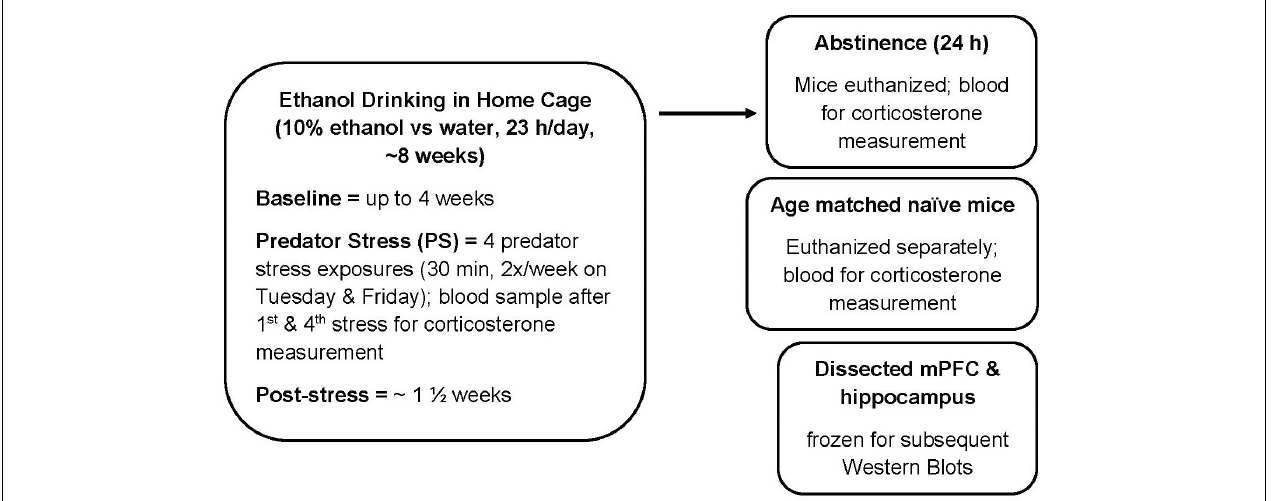
FIGURE 1 | Experimental timeline. Male and female C57BL/6J mice were treated as described. Ethanol drinking (10% ethanol vs. water) was measured for 23 h per day in the home cage. Predator stress (PS) exposure occurred twice per week for 2 weeks, where mice were exposed to dirty rat bedding for 30 min. After the fourth PS exposure, post-stress drinking was measured for approximately 1 1/2 weeks. Mice were euthanized at 24 h after the final drinking session (and consumption of water for 24 h). For the Western Blot study, tissue from age-matched naïve mice was used as the comparator group. mPFC, medial prefrontal